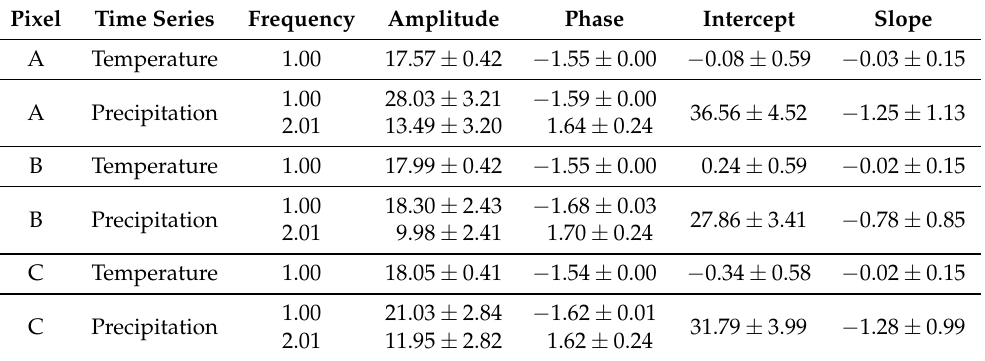
Table 3. The ALLSSA simultaneous estimated components of the weather time series for pixels A, B, and C displayed in Figures 2 and 7. The units of temperature, precipitation, and frequency are Celsius, mm, and cycles per year,